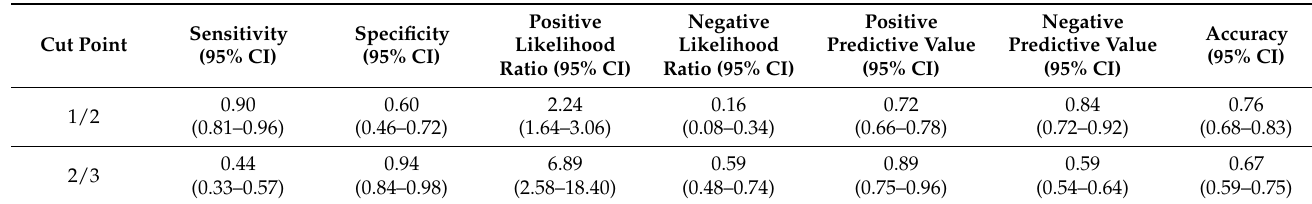
Table 2. Performance of the Cognitive Performance Scale using cut point of 1/2 and